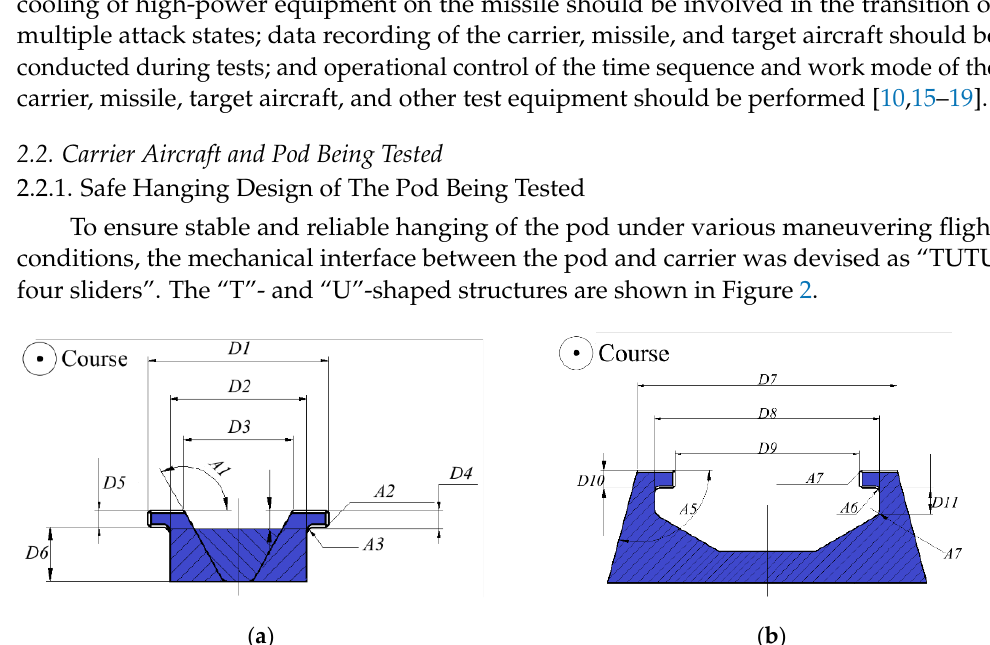
Figure 1. Composition of the “target situational awareness” test system.